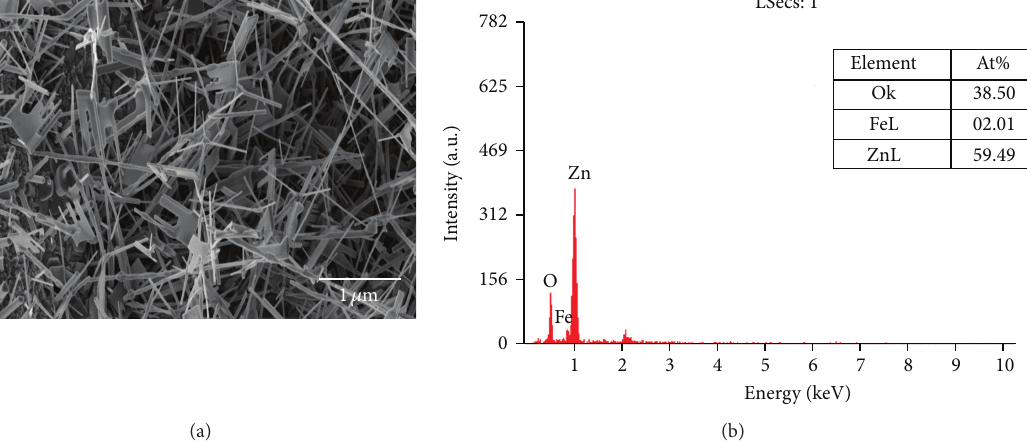
Figure 3: (a) SEM image and (b) EDS analysis of ZnO NRs that are grown on the stainless steel wire using CVD technique (650 ∘ C, 2 sccm O 2 , and 0.3 g Zn powder).